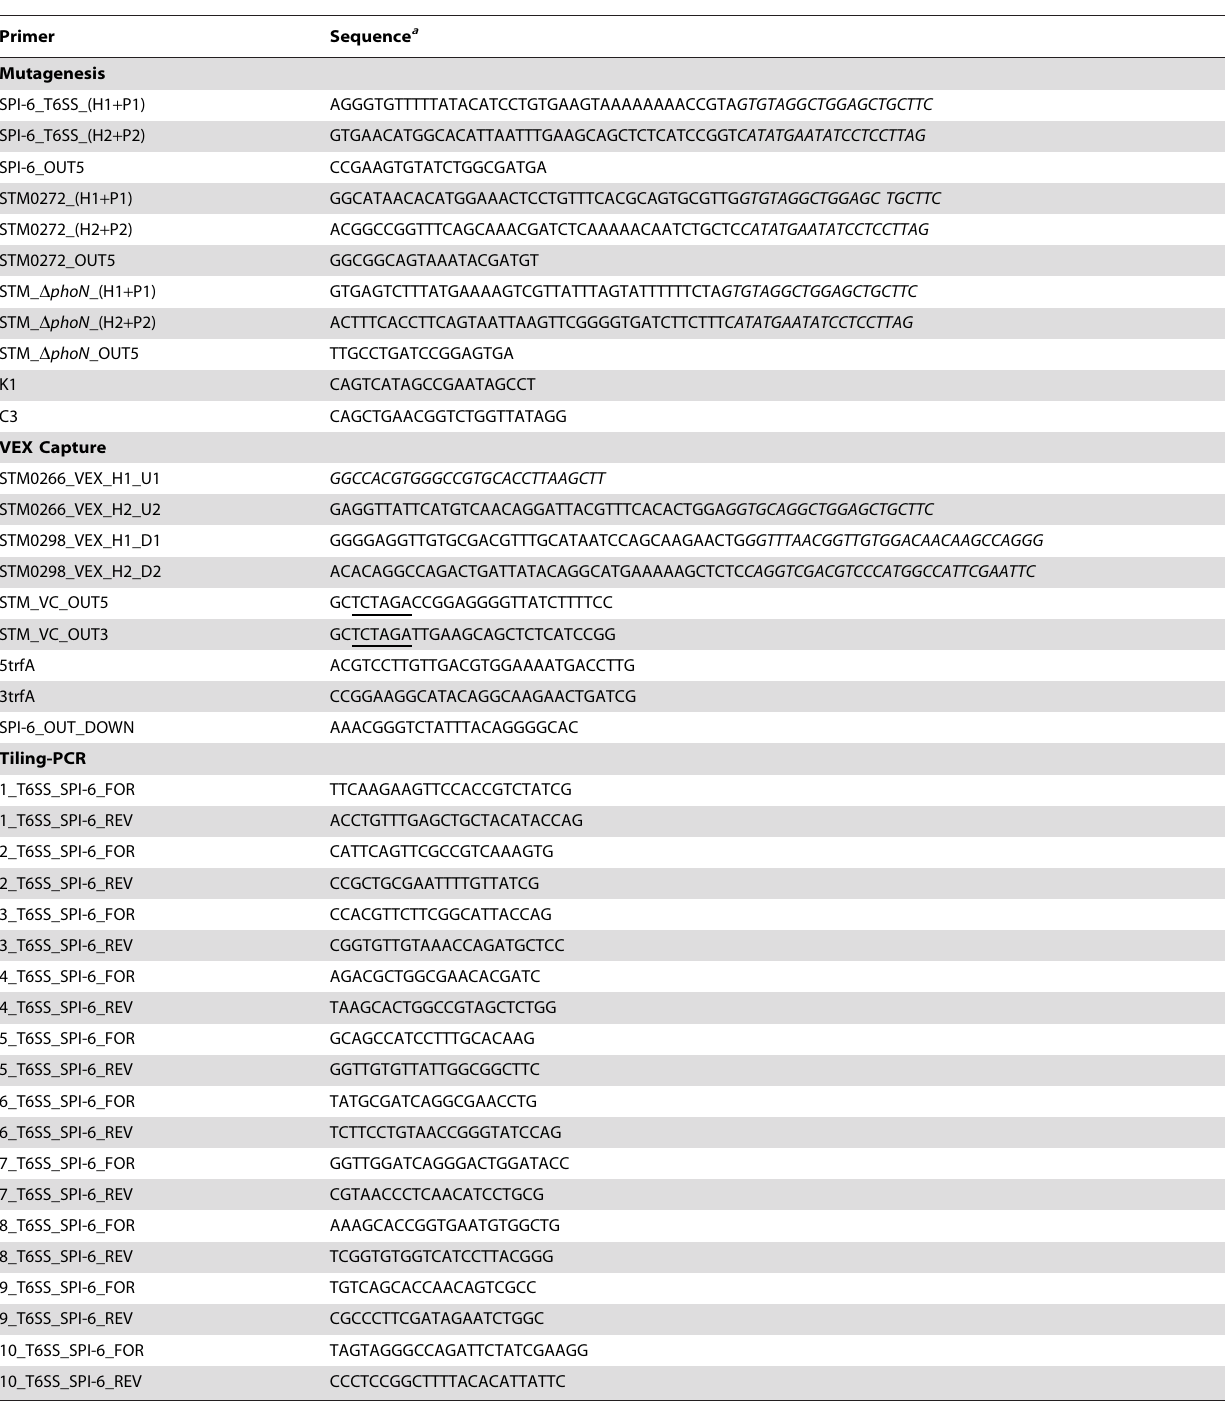
Table 2. Primers used in this study.